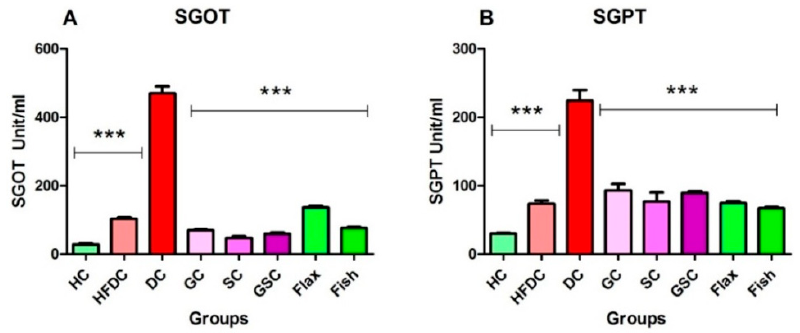
Figure 6. Flax and fish oil interventions lowered level of hepatic enzymes. Results are represented as Mean ± SE (n = 6 for each group). *** p ≤ 0.001, when compared with the DC group (Dunnett’s Multiple Comparisons Test). ( A ) Serum glutamic oxaloacetic transaminase level ( B ) Serum glutamic pyruvic transaminase level. HC: Healthy control, HFDC: High fat diet control, DC: Diabetes control,